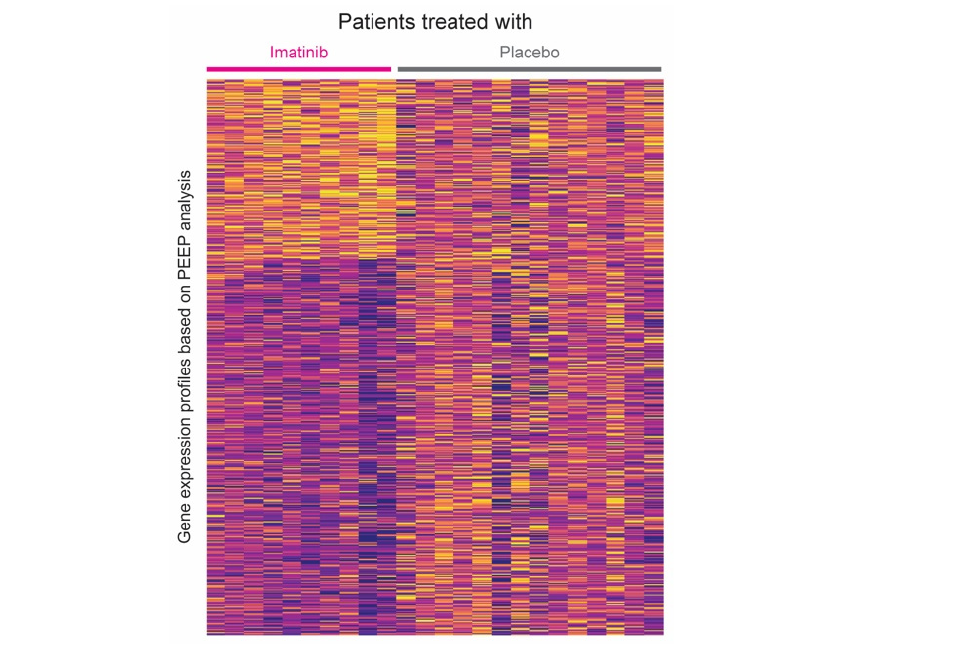
Unsupervised clustering on the gene expression profiles of the 557 genes based on the PEEP analysis identified that patients with FEV 1 improvement on imatinib ( n = 5) shared similar profiles (Figure 3). Clustering yielded distinct groups of patients corre- sponding to percent change in FEV 1 : Two patients (green; entitled strong responders rel- ative to the other groups) had an improvement greater than 20% while three patients (yel- low; entitled weak responders) had a 5–10% increase in FEV 1 and five patients (in gray) had <5% response (entitled non-responders). The FEV1 response is a continuous variable [13]; therefore cut-offs for analyses were objectively based on the clustering results and not pre-specified. In an exploratory analysis, we found that the average decrease in serum tryptase during between pre- and post-treatment visits was greatest among FEV 1 strong responders, lower for weak responders, and least among non-responders (Supplementary Figure S1).